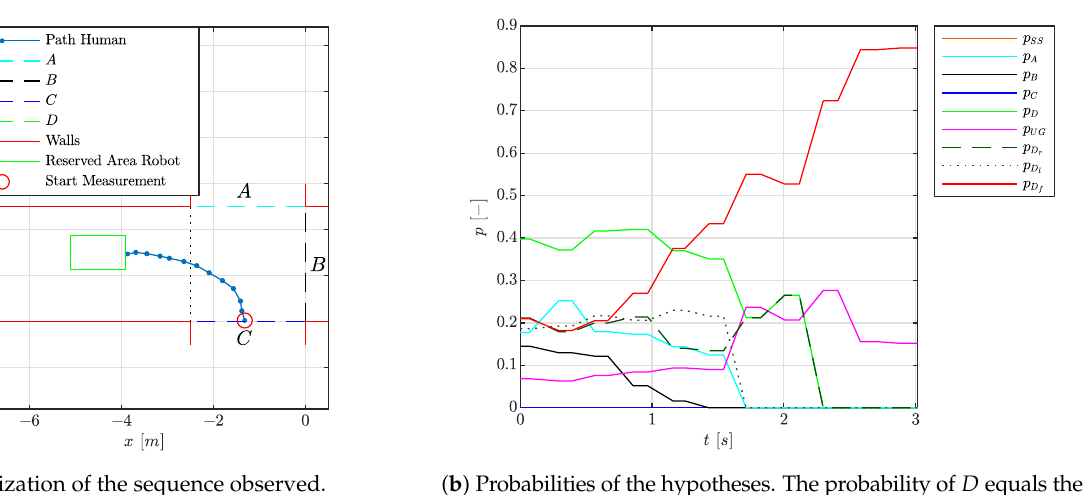
Figure 6. Visualization of the experiment where a person is walking towards the